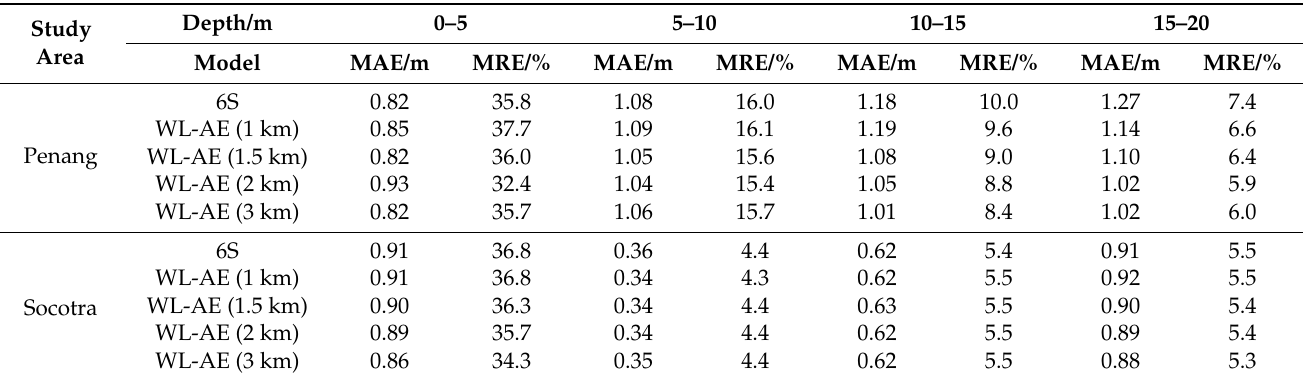
Table 4. Accuracy of the Segmental Bathymetric Inversion Results in Penang and Socotra (interval: 5 m).